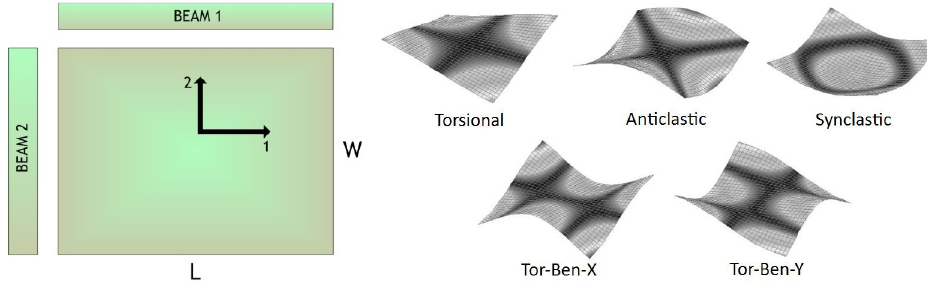
Fig. 2. Cutting two test beams Fig. 3. Mode shapes of a Poisson plate